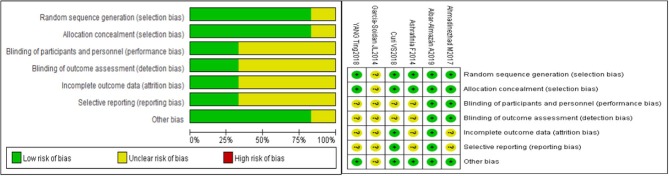
Risk of bias graph.